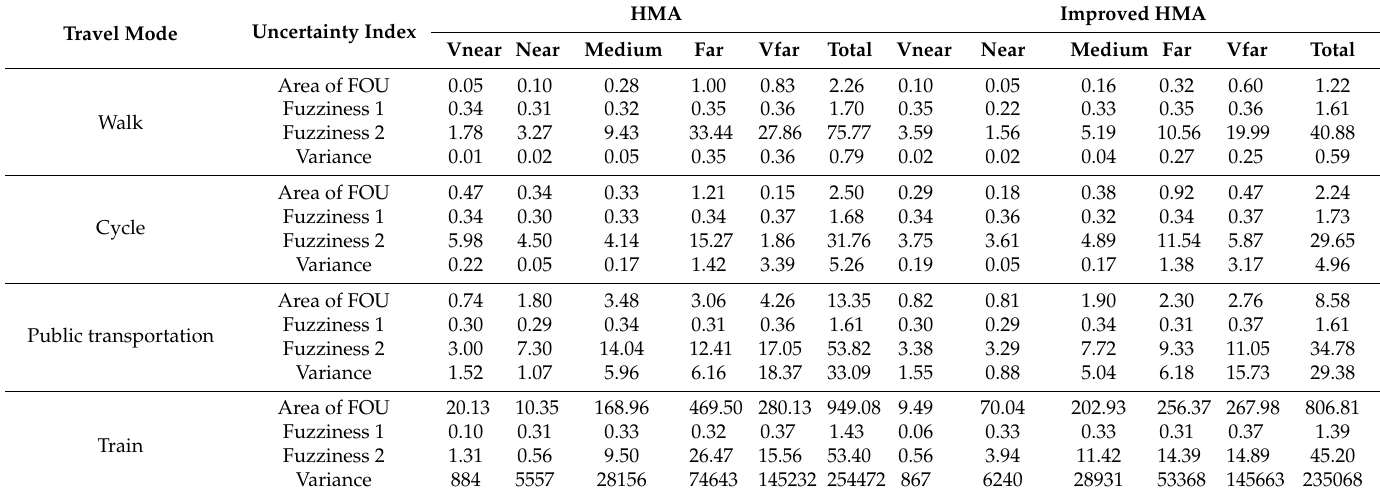
Table 2. Uncertainty indices of IT2 FSs corresponding to five distance words for four travel models modeled by the HMA and improved